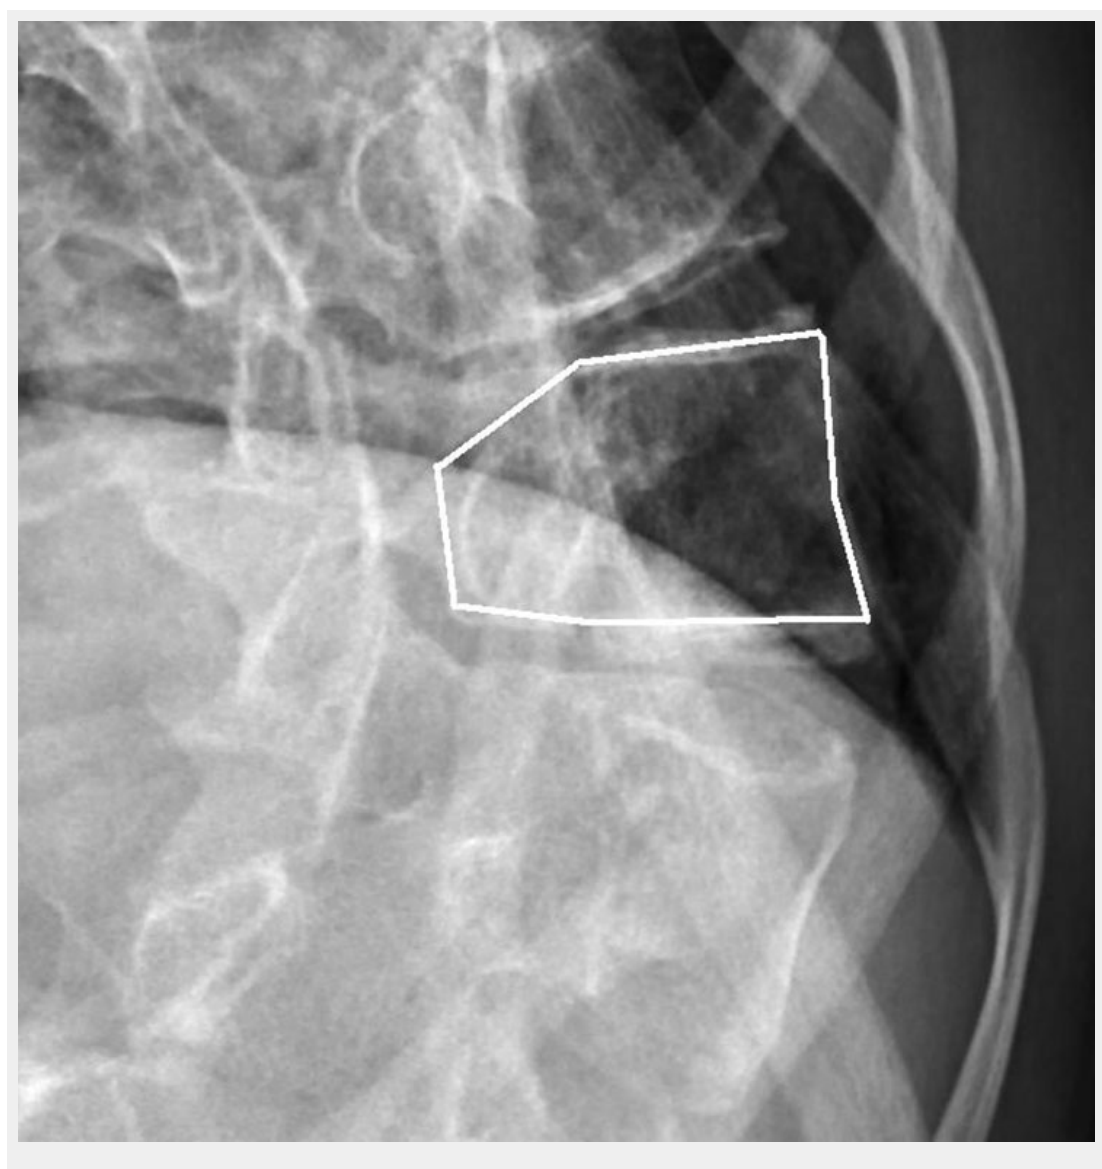
Figure 1 B High loads on a growth plate leads to diminuition of growth and vice versa [25]. A typical example is the wedge shaped apical vertebra in a scoliotic curve due to high load on the concave (inner) side of the